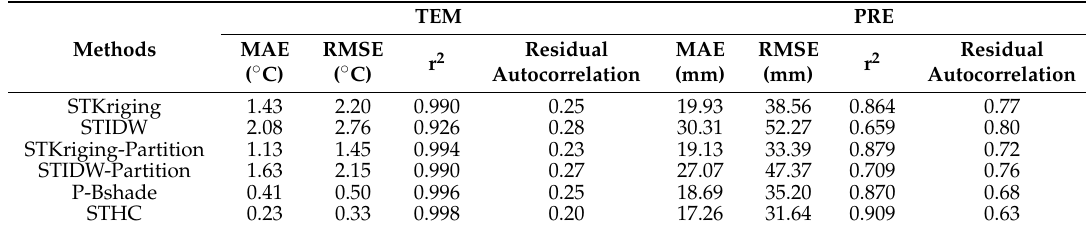
Table 1. Experimental results of different interpolation methods.